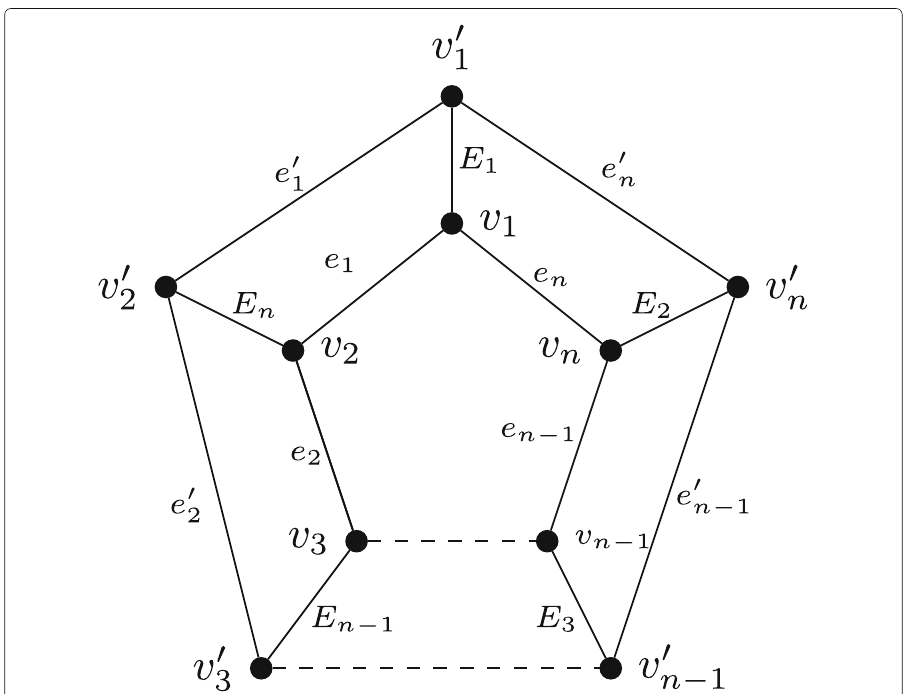
(cid:2) Fig. 18 n with ordinary